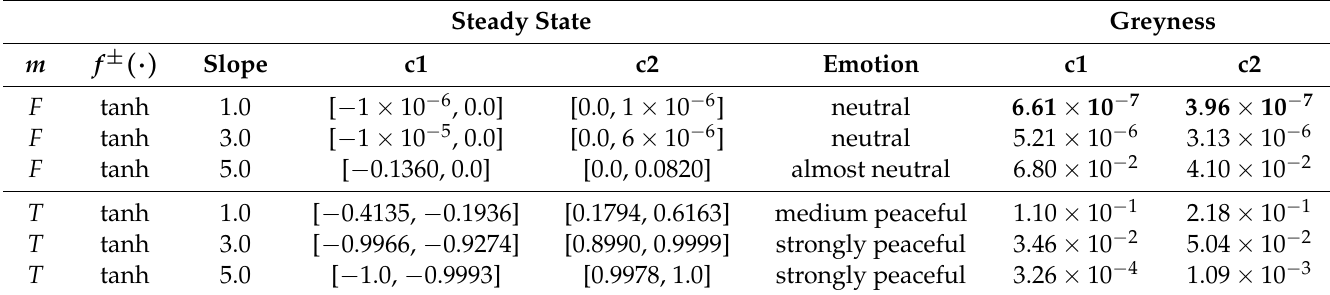
Table 3. Results of experiment 2.